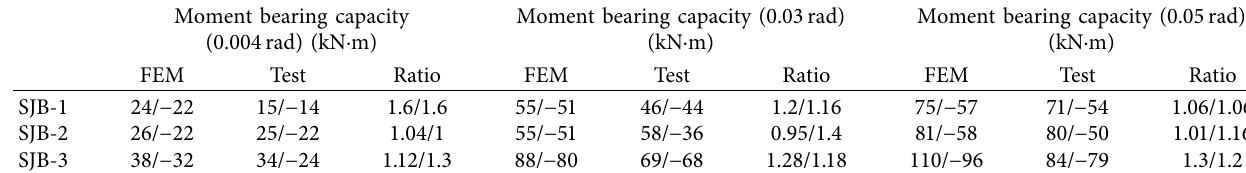
Table 5: Comparison between the SJB experimental and finite element analysis results.